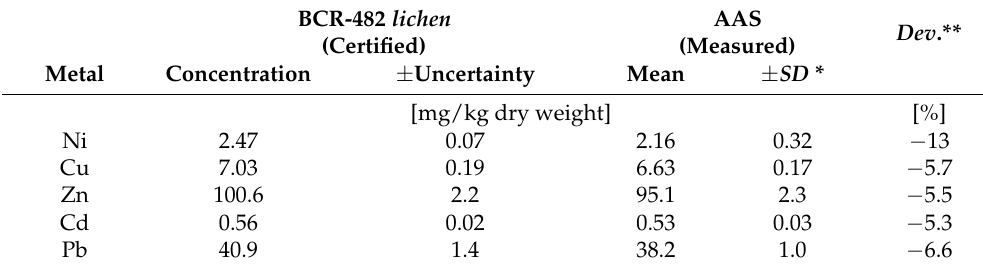
Table 1. The instrumental detection limits ( IDL ) and instrumental quantification limits ( IQL ) for the iCE 3500 spectrometer [mg/L] [32]. Metal IDL IQL Ni 0.0043 0.050 Cu 0.0045 0.033 Zn 0.0033 0.010 Cd 0.0028 0.013 Pb 0.0130 0.070